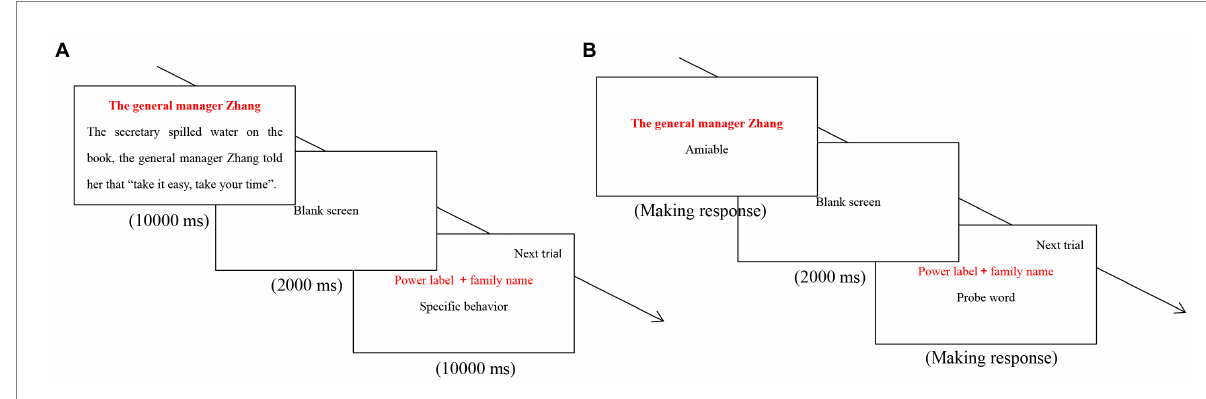
FIGURE 3 Trial structures of the study phase (A) and recognition phase (B) in the modified false recognition